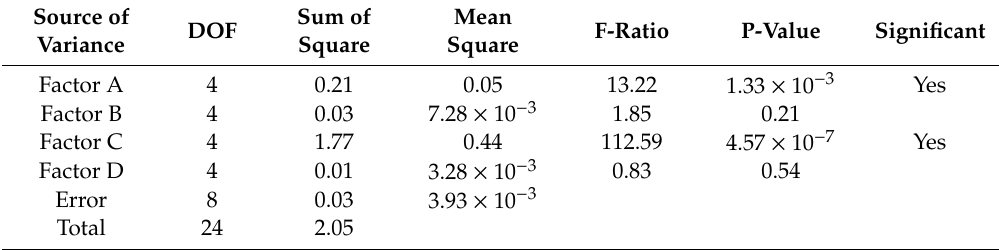
Table 8. Variance analysis of the DEI as obtained from the building damage assessment. Source of